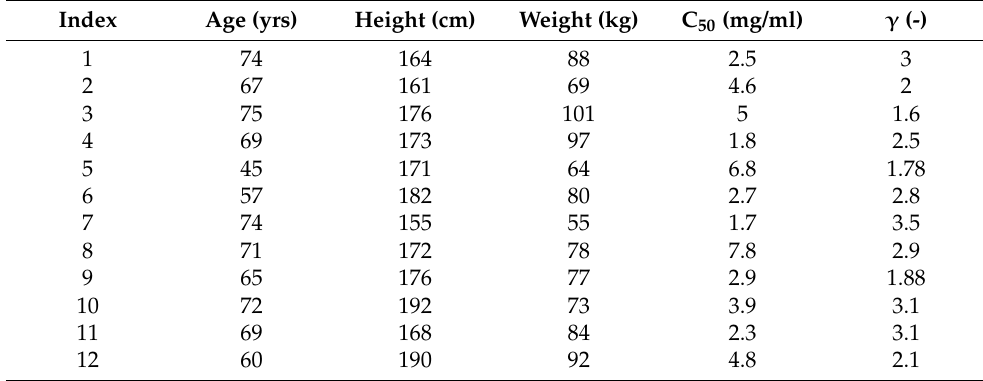
Table 1. Representative Patient Database for Propofol-to-BIS with pharmacokinetic Model Biometric Values and PD Model Sensitivity Values